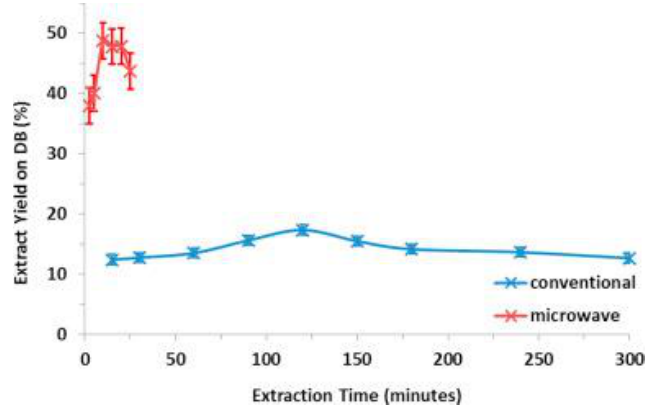
Figure 5. Effect of extraction time on extract yield (DB) at 70 °C [50].